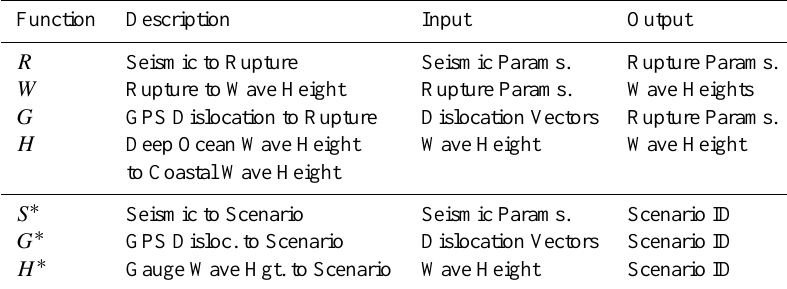
Table 1. Common forecast functionals in tsunami forecasting. Function Description Input Output R Seismic to Rupture Seismic Params. Rupture Params. Rupture to Wave Height Rupture Params. Rupture